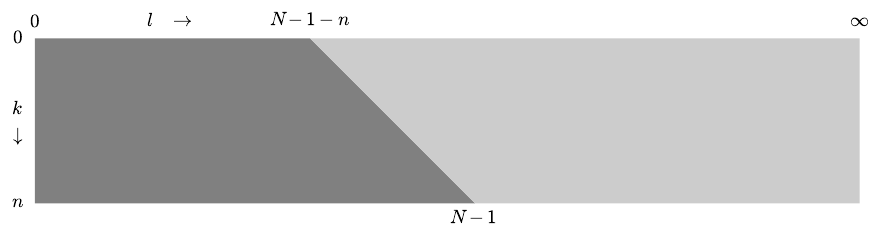
Figure 1 . Illustration of the domain of summations over k and l in (4.4). The domain to be summed over is the dark shaded area. Instead, we sum over the semi-in(cid:12)nite rectangle and subtract the sum over the light shaded